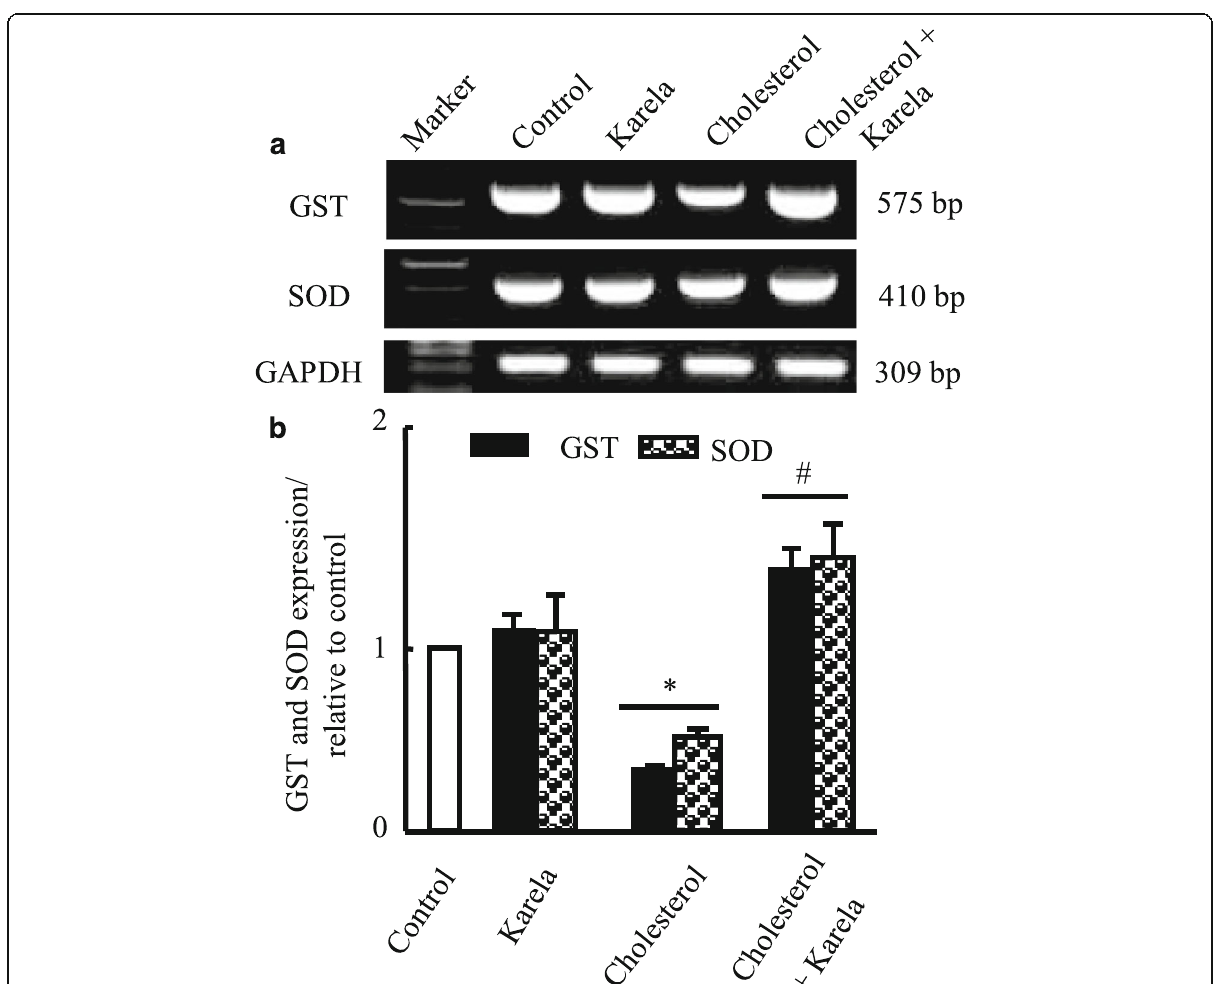
Fig. 3 Protective effect of karela on changes in antioxidants expression induced by hypercholesterolemia in liver. Hypercholesterolemic rats were administered karela for 4 consecutive weeks. Total RNA was extracted from liver tissues and the expressions of GST and SOD were analyzed by semi-quantitative RT-PCR analysis. Values are means ± SE of 10 rats. * P < 0.05 Vs control group; # P < 0.05 VS hypercholesterolemic group. Upper panels ( a ) are mRNA expression of examined genes. Lower columns ( b ) are densitometric analysis of gene expression for upper